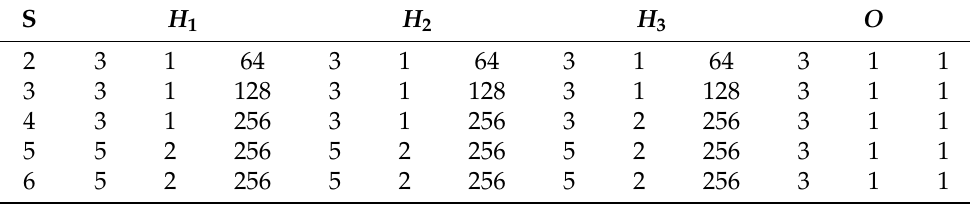
Table 1. The detailed convolutional structure of the prediction head. H denotes the feature en- hancement module in each prediction header, each prediction header contains three convolutional layers— H 1 , H 2 , H 3 —and each convolutional layer is followed by a ReLu activation function. The table shows the parameters of each convolutional layer; for example, 3, 1, 64 indicates a convolutional layer with convolutional kernel size of 3, padding of 1, and channel number of 64. O represents the output layer, which transforms the multi-channel features into a single-channel activation